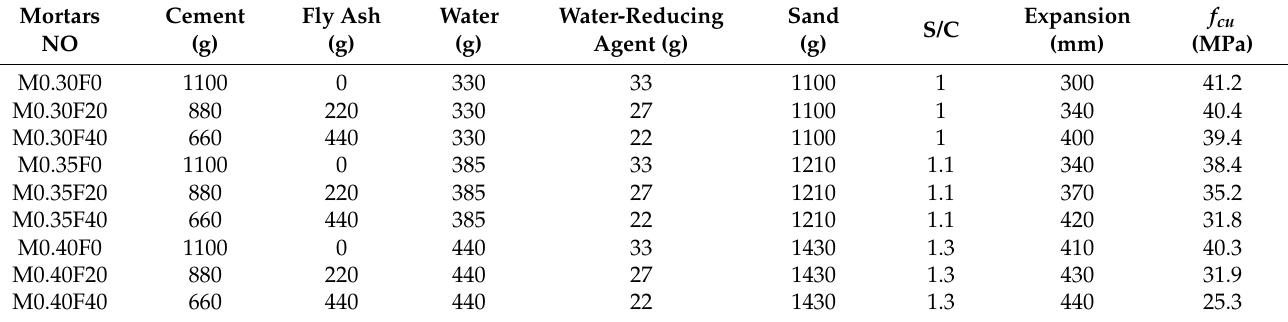
Table 6. Mixture design and compressive strength of recycled mortar.